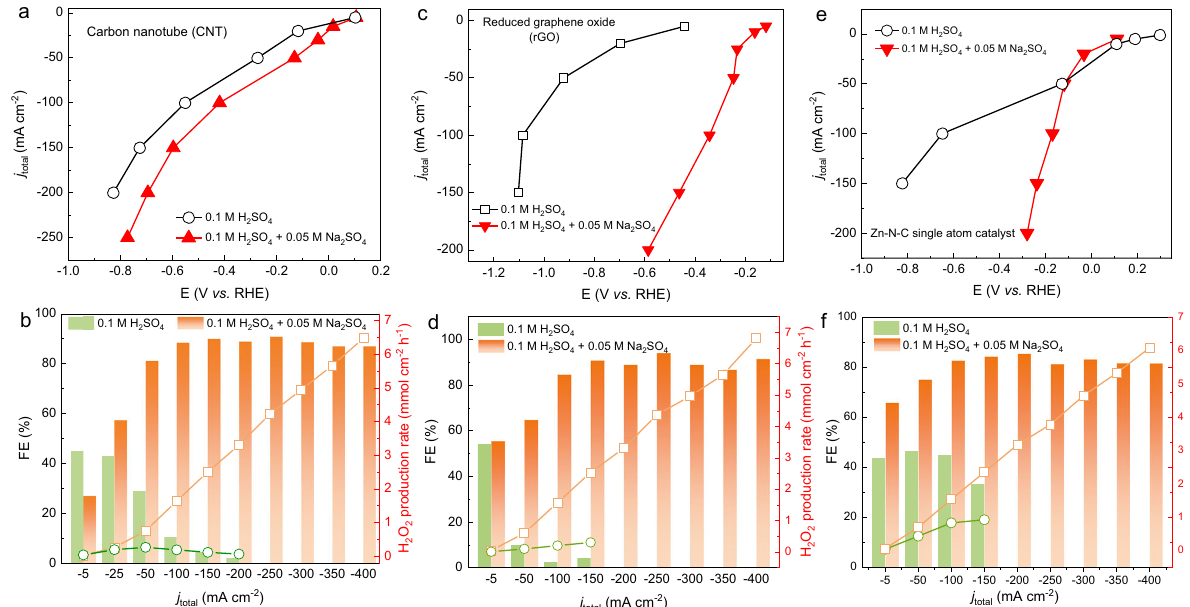
Fig. 4 The Na + effect towards electrochemical production of H 2 O 2 on diverse carbon-based electrocatalysts. The I-V curve of ORR in 0.1 M H 2 SO 4